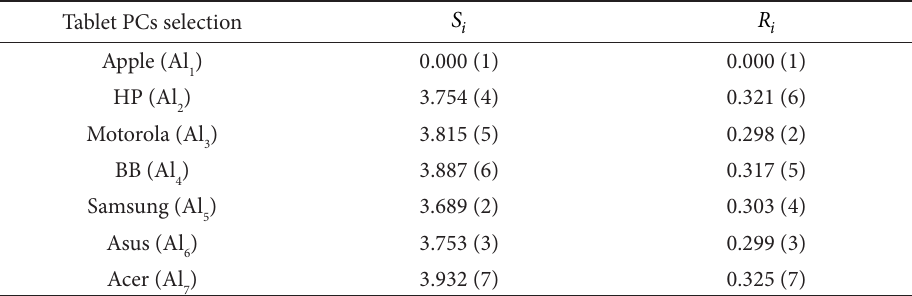
Table A5. The values i S and i R by VIKOR Tablet PCs selection